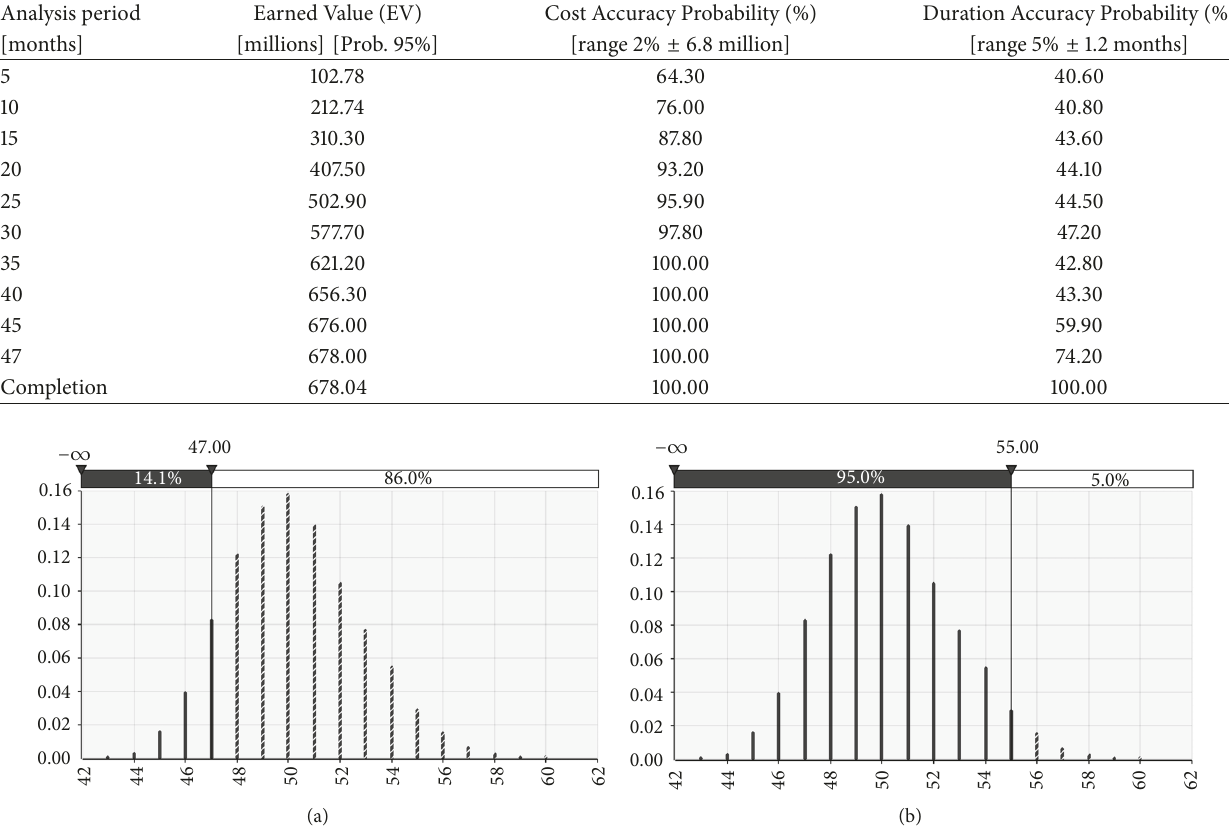
Table 8: Accuracy probability rates in cost forecasts (EVM) and duration forecasts (ES) for the Sopladora project.